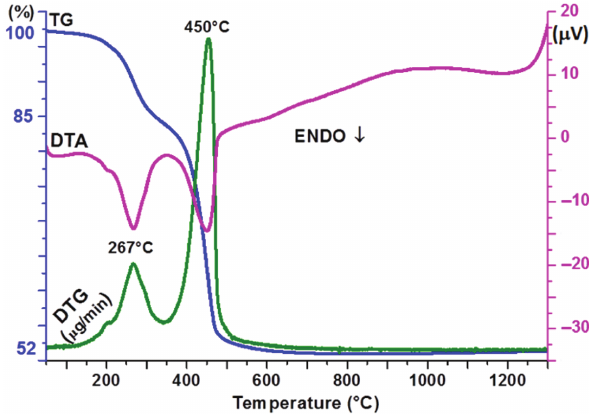
Figure 3: DTA/TG/DTG curves of Mg 3 SiO 5 : Eu 3+ , Dy 3+ .